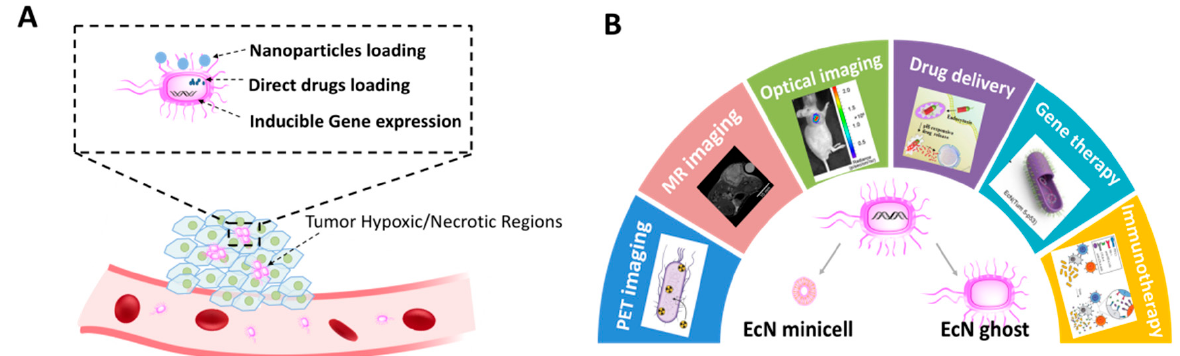
Figure 1. EcN-mediated tumor imaging and therapy. ( A ) Schematic illustration of the ability of preferential tumor colonization in hypoxic regions. EcN can be designed to load drugs or integrate nanoparticles and express exogenous genes; ( B ) Schematic diagram of the strategies of various imaging modalities and treatment patterns for EcN, EcN minicell, and EcN ghost.